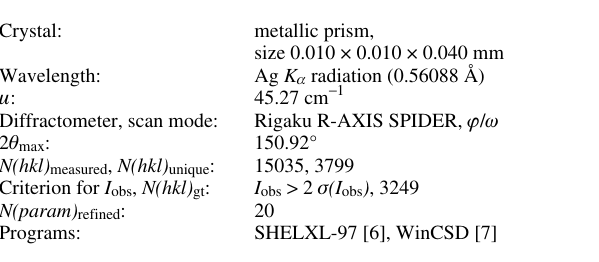
Table 5. Data collection and